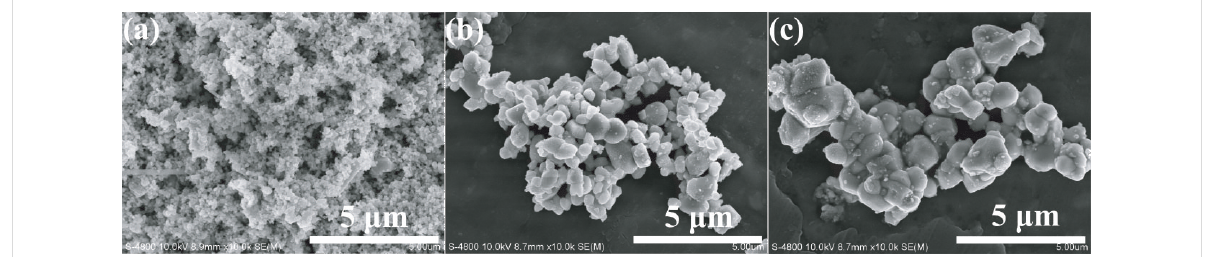
Figure 2: SEM images of Ag 2 CrO 4 samples obtained from different methods: (a) microemulsion, (b) precipitation, and (c) hydrothermal.